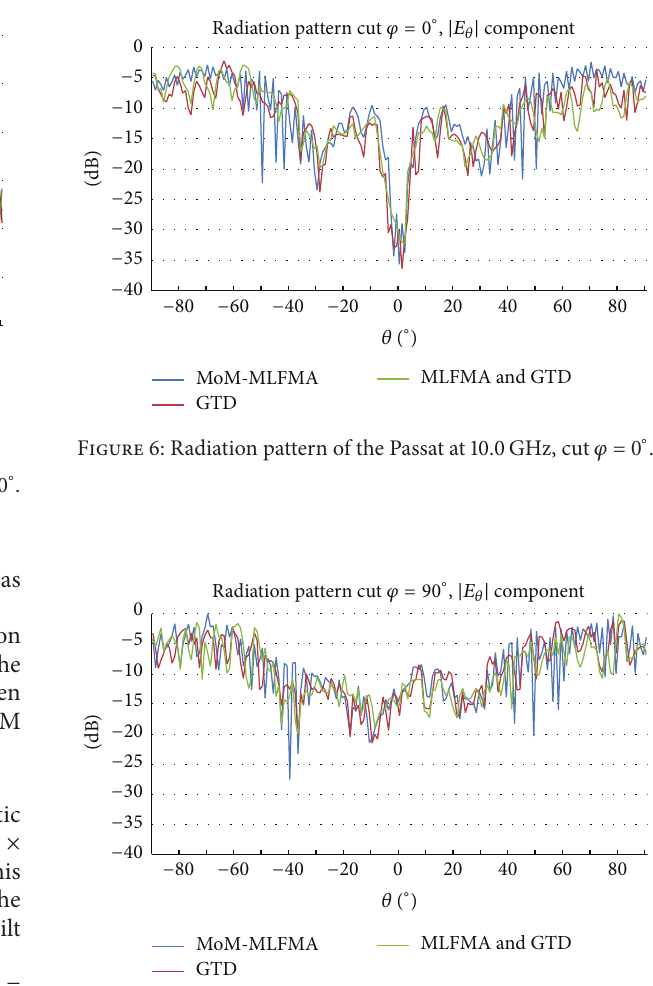
Figure 7: Radiation pattern of the Passat at 10.0GHz, cut 𝜑 = 90 ∘